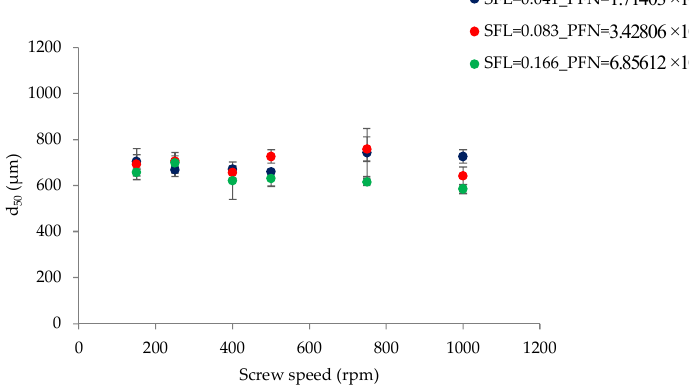
Figure 4. Median granule size of lactose at different SFL–PFN at varying screw speed (L/S 0.048).